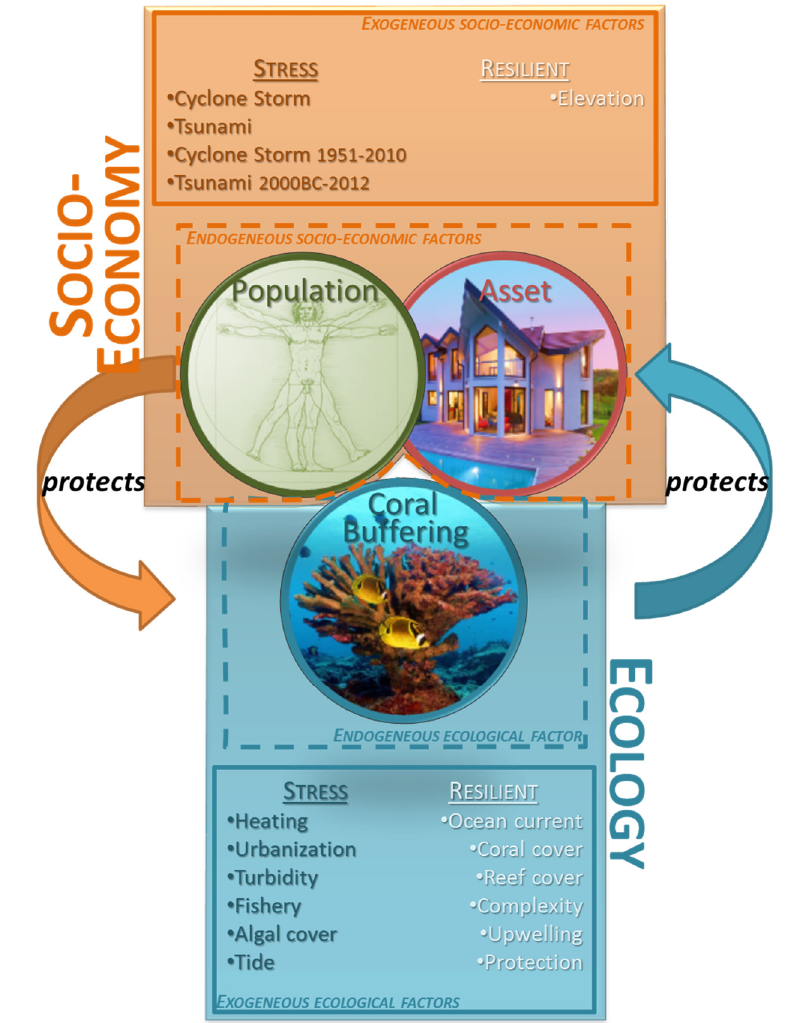
Figure 2. Conceptual framework centered on the endogenous socio-economic (population/asset) and ecological (coral buffering) factors influenced by exogenous stress-inducing and stress-mitigating (resilient)